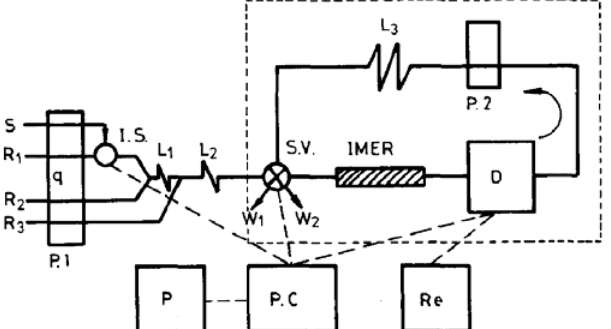
Figure 2. Open-closed configuration for determination of GPT. P.1, P.2: peristaltic pump; I.S.: injection system; S.V.: selecting valve; R reactor; D: spectrophotometer flow-cell; P.C: computer; P: